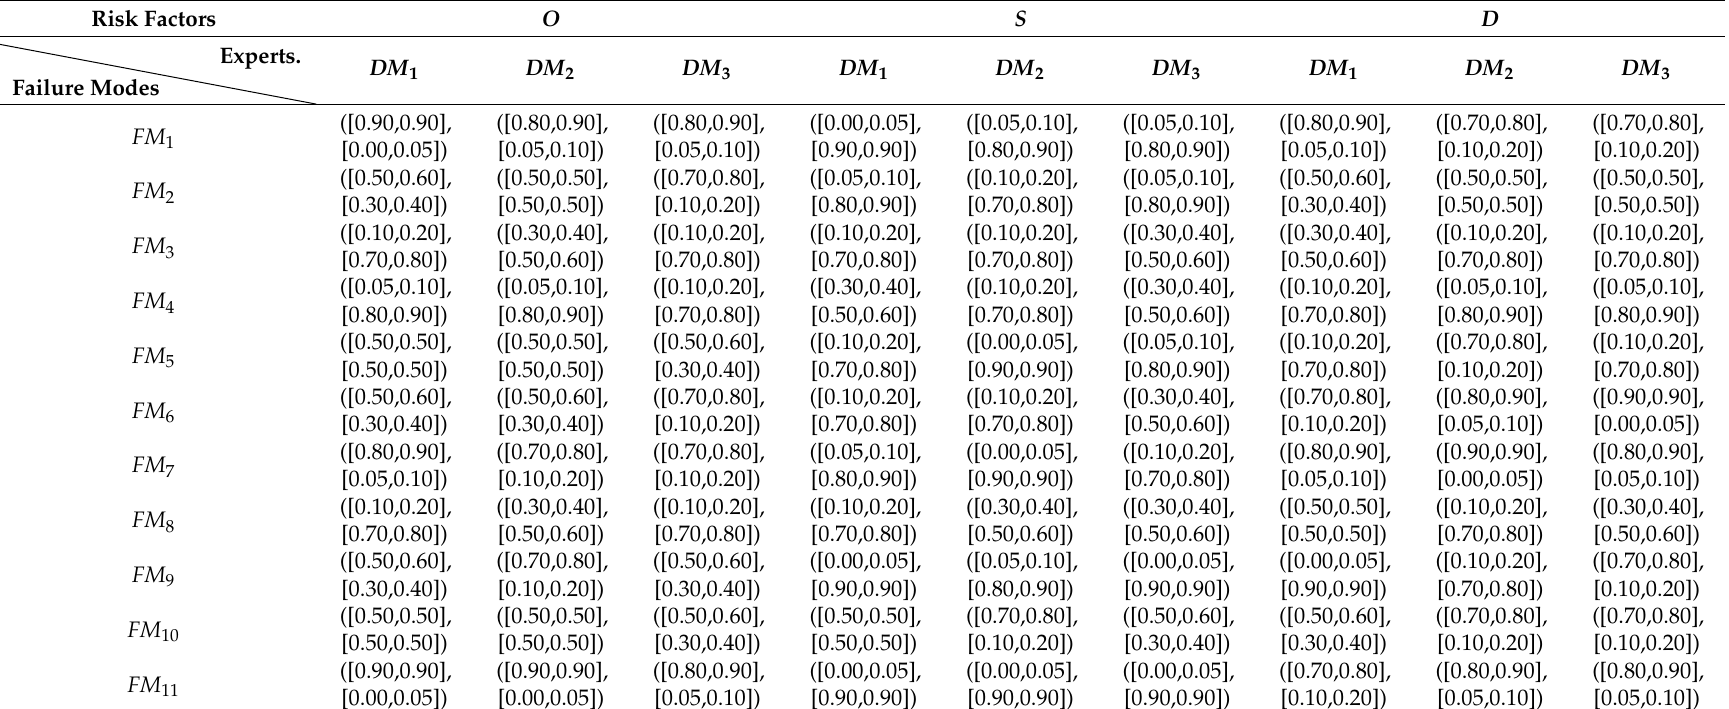
Table 3. Interval-valued intuitionistic fuzzy evaluation